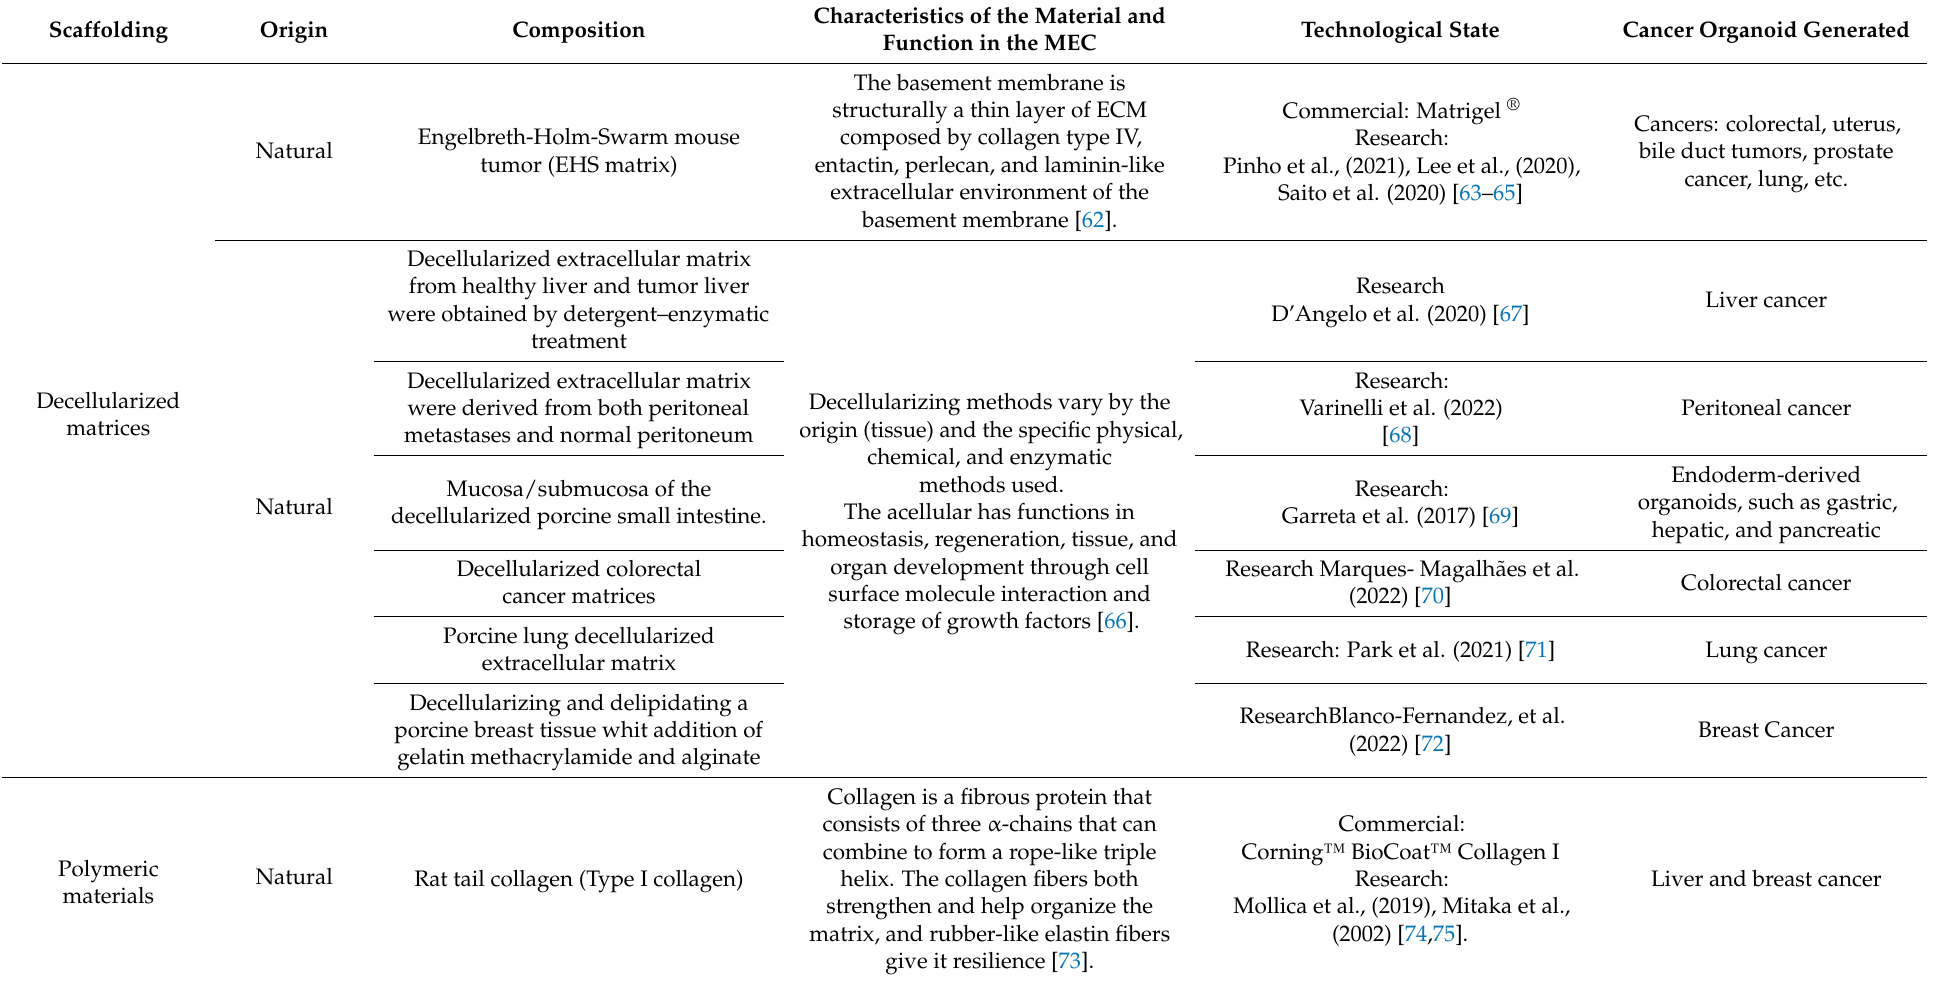
Table 1. ECM biomimetic materials for the development of